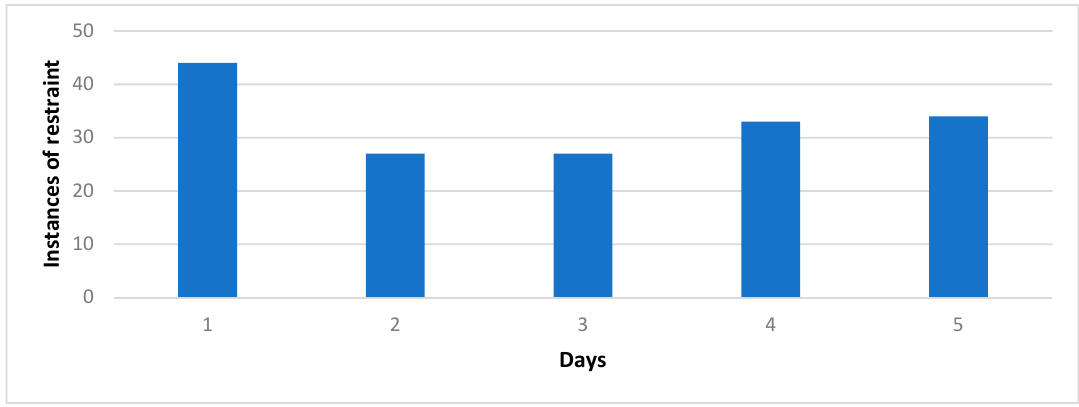
Figure 1. Total instances of restraint over five separate days on Acute Medical and Frailty Wards.